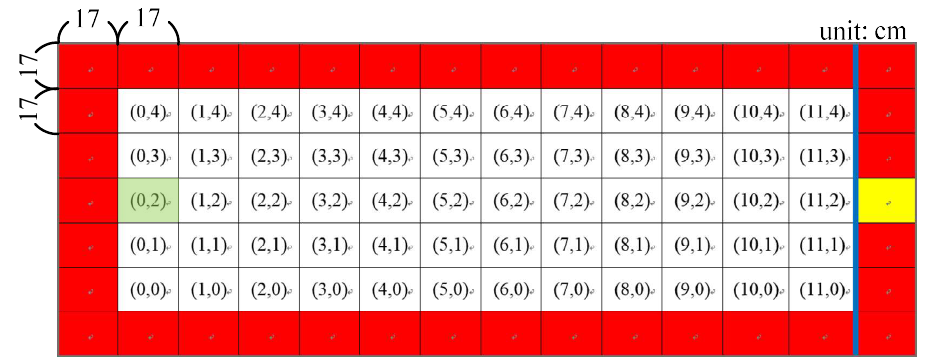
Figure 5. Coordinate representation of the training field in the horizontal plane of the automatic training platform.